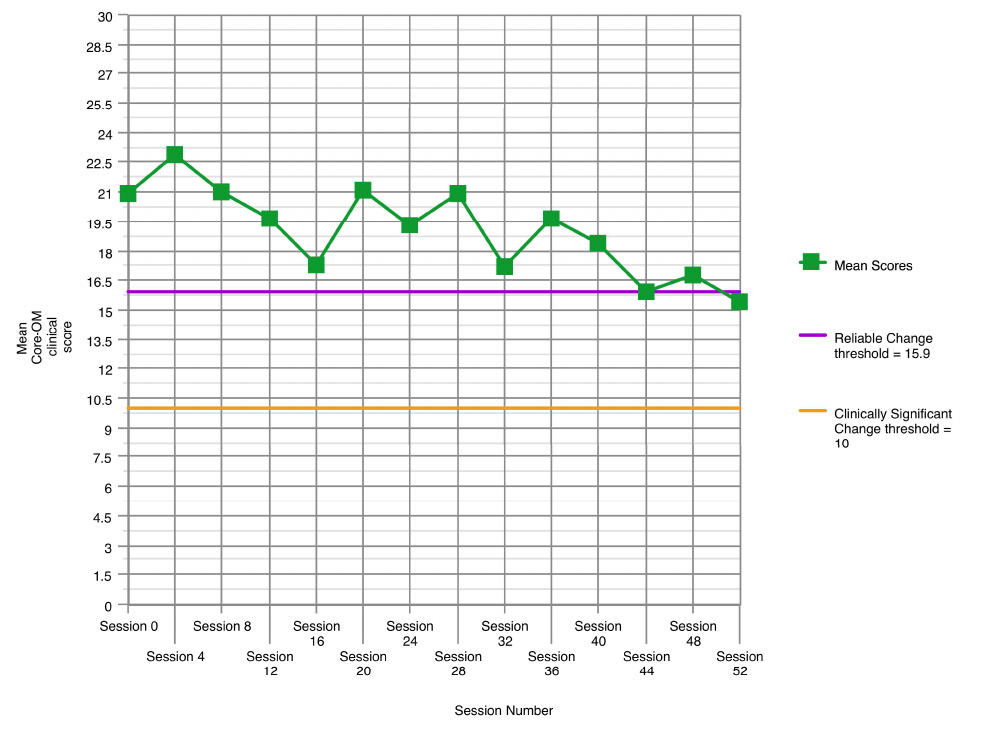
Figure 1: Table 4: Mean Clinical Core-OM score: 8 long-term clients